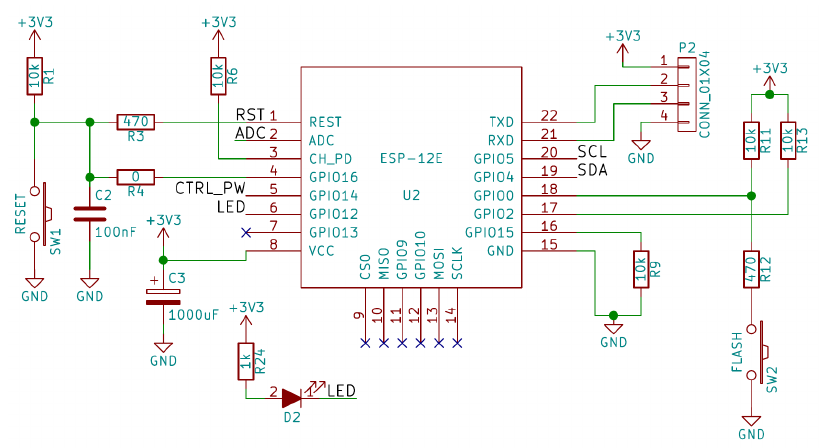
Figure 6. Schematic corresponding to the elements of the ESP-12E